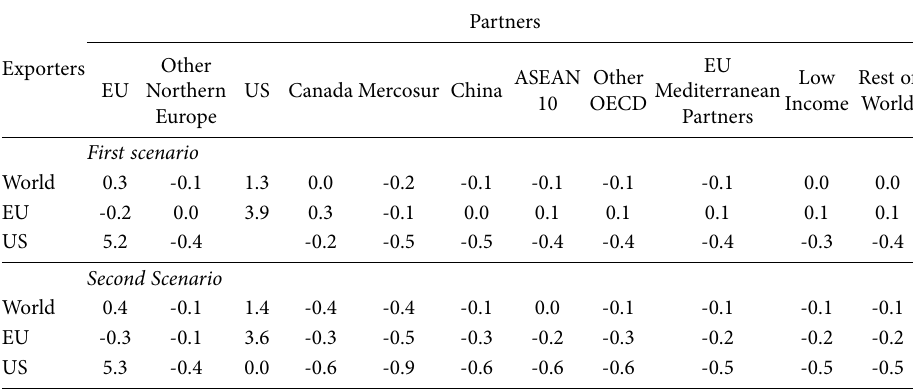
Table A4. Export volume by region for overall manufacturing sectors [%